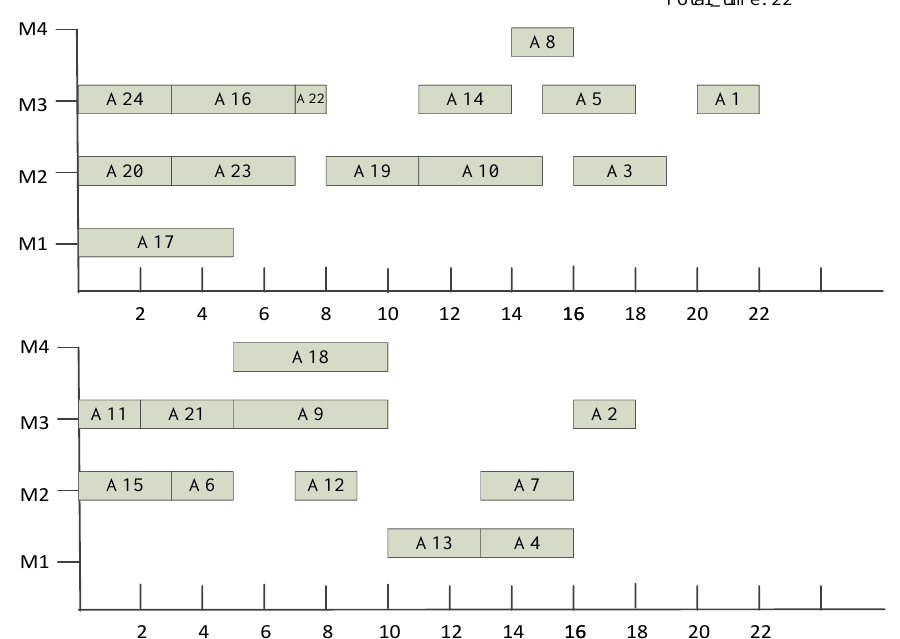
Figure 9. Gantt chart of algorithm scheduling results in the Ref. [16].